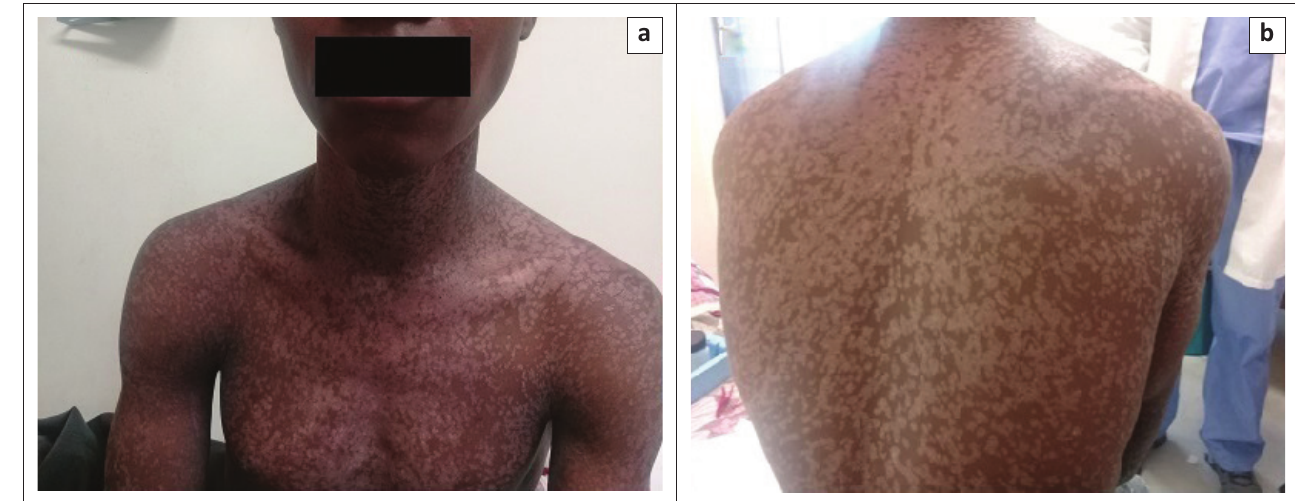
FIGURE 1: (a and b) Physical examination revealed a generalised hypopigmented macular rash diagnosed as verruca plana .